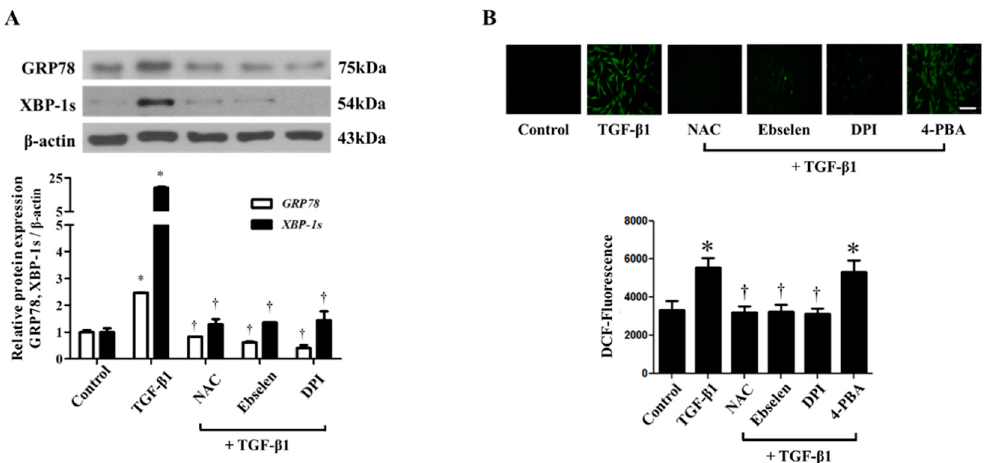
Figure 5. ROS scavengers, NAC, ebselen, DPI inhibit TGF- β 1-induced ER stress in nasal fibroblasts. ( A ) Nasal fibroblasts were pretreated with ROS scavengers, NAC (3 mM), ebselen (10 μ M), and DPI (2 μ M) and then stimulated with TGF- β 1 (5 ng/mL) for 72 h. The protein expression of ER stress markers, GRP78 and XBP-1s was determined by Western blotting. ( B ) ROS production was assessed by fluorescence microscopy using 2,7-dichlorofluorescein diacetate (DCFH-DA). Scale bar = 100 μ m. Data are presented as mean ± SEM and are representative of at least three independent experiments. * p < 0.05 vs. control, † p < 0.05 vs. TGF- β 1 treatment.